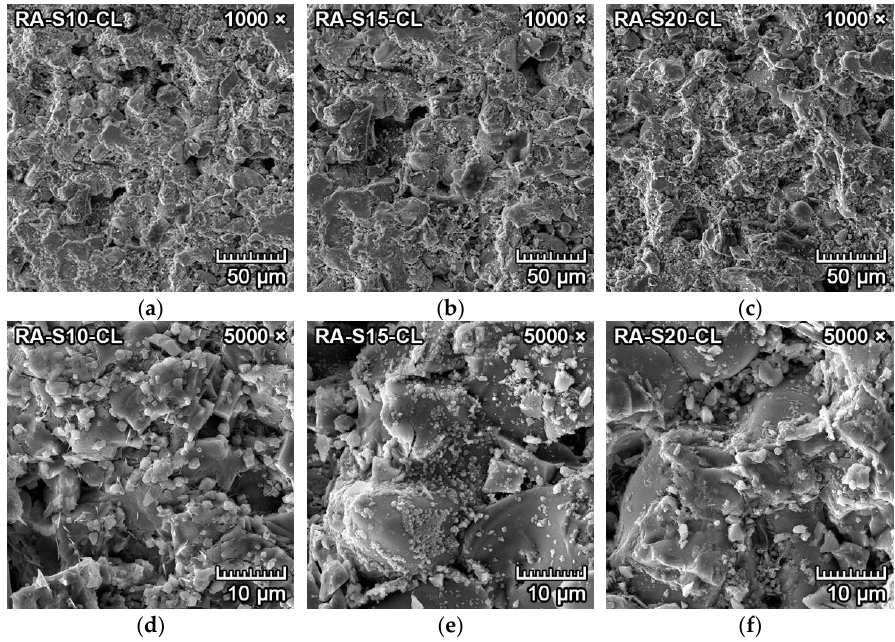
Figure 9. SEM microstructure of the transition zone between clinker and forsterite – spinel ceramics of reactive alumina – based mixtures RA-S10, RA-S15 and RA-S20, with a magnification of 1000× ( a – c ) and a magnification of 5000× ( d – f ).